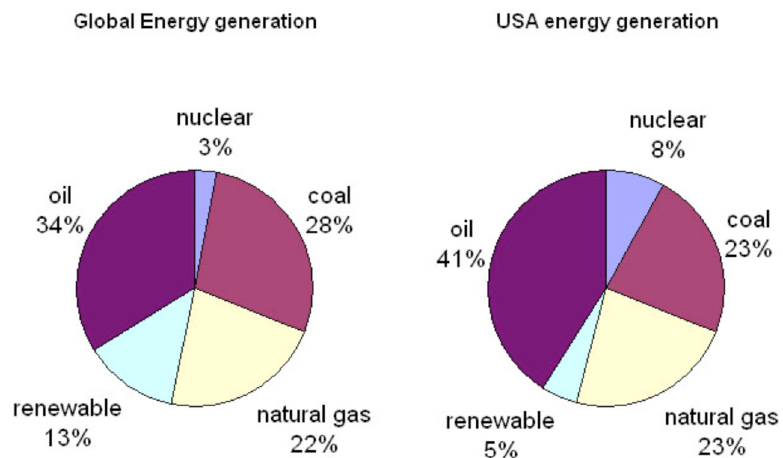
Fig. 1. Global and USA energy generation scenarios.